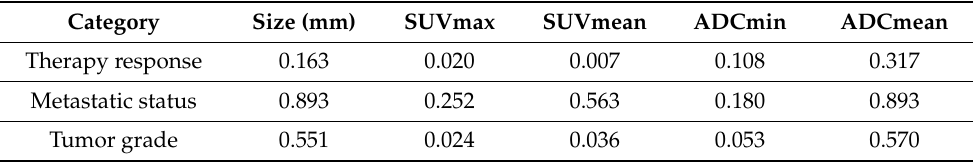
Table 4. Calculated p -values for the differences in the quantitative imaging parameters in dependence of the outcome variables.